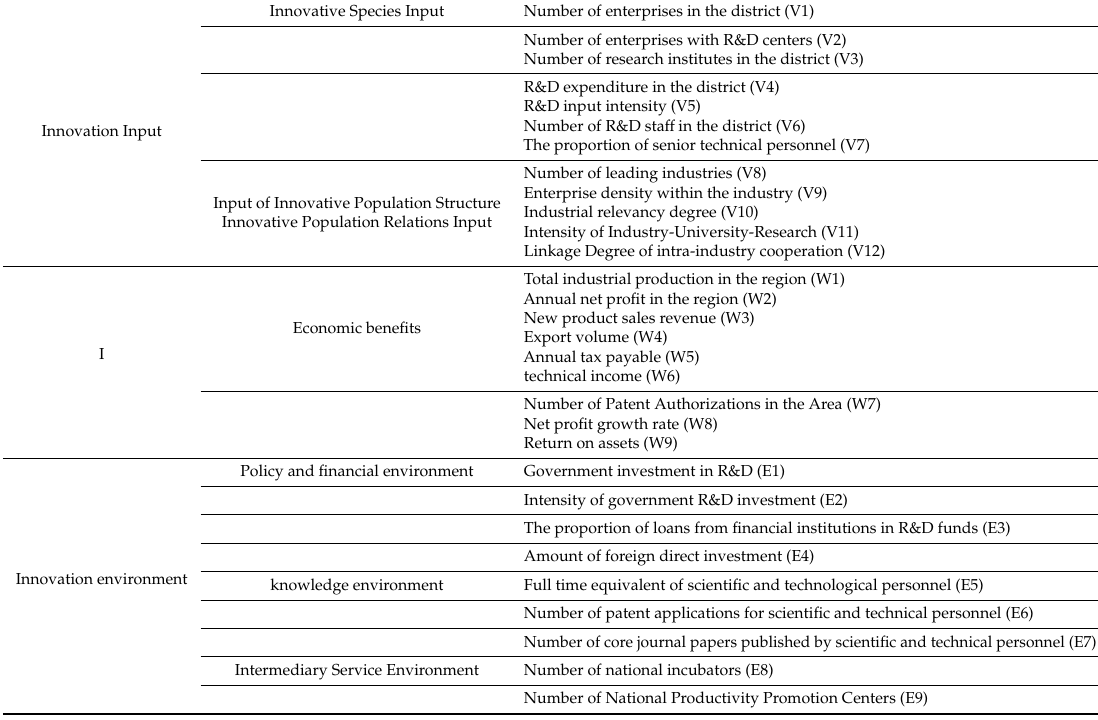
Table 1. Evaluation Index System of Platform Innovation Ecosystem in High-tech